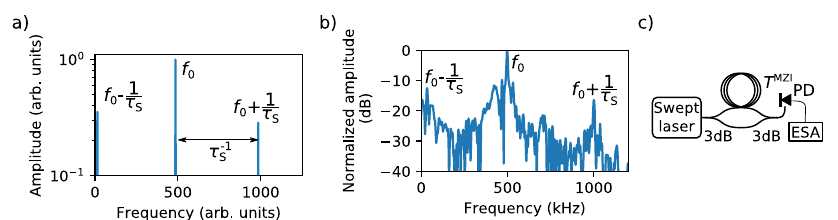
Fig. 3 Calculated and measured spectra as acquired from the sweeping laser in an asymmetric MZI. a Spectrum of the detector current, as calculated from the amplitude and phase evolution shown in Fig. 2b, c. The center frequency f 0 and the fi rst higher-order components with frequencies f 0 ± 1/ τ s are indicated. b Measured frequency spectrum of the photodetector in the asymmetric Mach – Zehnder interferometer experiment (see c ) and Sec. 5.2. The graph shows the absolute value of the Fourier transform of 512,000 data points, recorded at a sampling rate of 80 MS/s. The time delay T MZI = 1 ns was realized with a 20.6-cm-long optical fi ber. Together with the tuning speed (500 THz/s) of the laser, the fundamental modulation frequency of the detector = 498 kHz. Higher harmonics stem from the stepwise tuning scheme of the laser source and can be eliminated from the spectrum by a band current is f MZI 0 pass fi lter centered at f 0 . c Setup of the Mach – Zehnder interferometer experiment, with a fi ber delay T MZI , 3 dB couplers (3 dB), and a photodiode (PD) connected to an electrical spectrum analyzer (ESA).